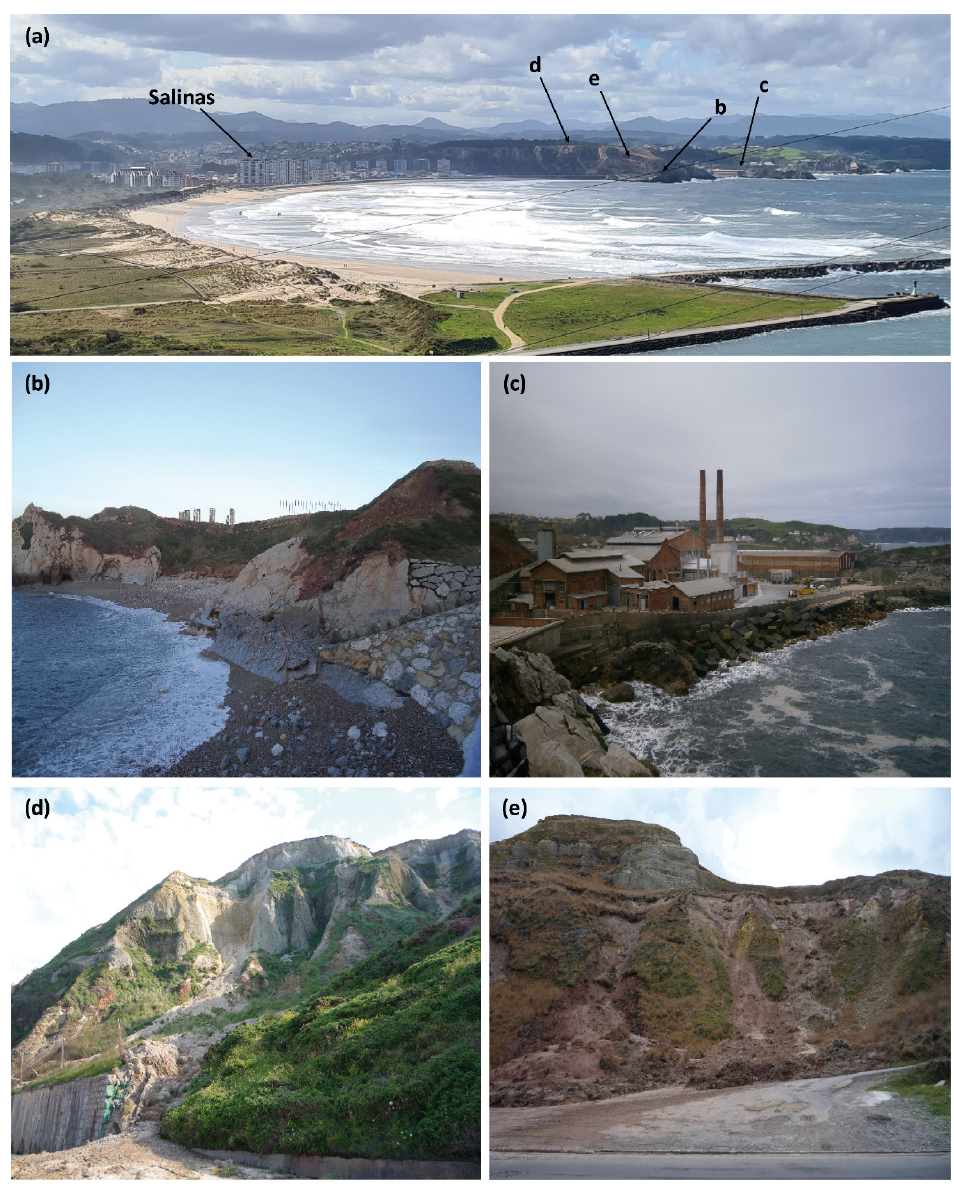
Figure 6. Salinas area views. ( a ) Salinas town panorama; ( b ) cliffs and beach of La Peñona; ( c ) industries located at the El Cuerno beach; ( d ) and ( e ) debris flows on the Salinas-La Peñona road in 2010 and 2008, respectively. Figure 7 shows the LOS mean velocity maps obtained by PSIG and GEP in the Salinas Area. According to PSIG measurements (Figure 7a, Table 4), the VLOS rates obtained range between − 10.2 and 5.3 mm year − 1 . The total number of PS detected was 3417 (885.2 PS km − 2 ). They were distributed between the urban, rock cliff, and outcrop reflectors. With respect to the accumulated displacement measured, a minimum and maximum of accu- mulation of -27.6 and 23.5 mm were detected. As to LOS rates measured, the stable PS represents 98.3% (3360 PS). In the case of negative PS (from − 10.9 to − 2.5 mm year − 1 ), there are only 11 PS (0.3%). The positive PS with velocity rates of 2.5–4.6 mm year − 1 (46 PS, 1.4%)